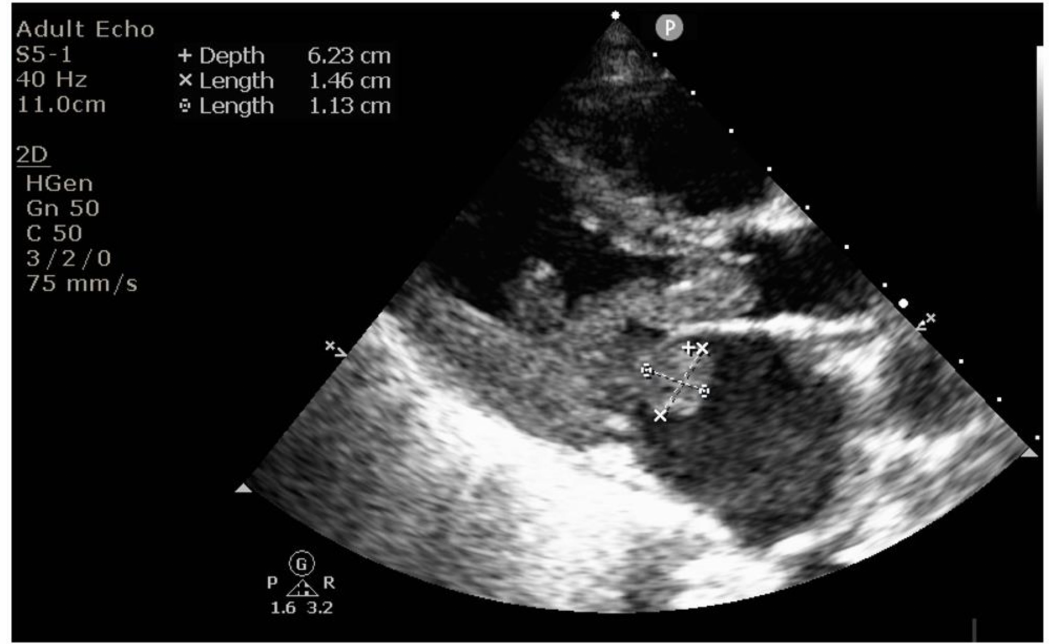
Figure 4. Mitral endocarditis below and above the mitral leaflets, on both atrial and ventricular